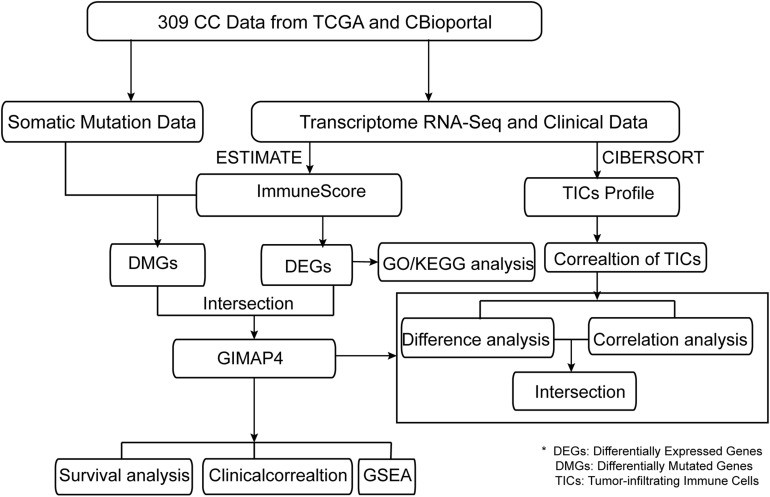
The analysis workflow of this study.